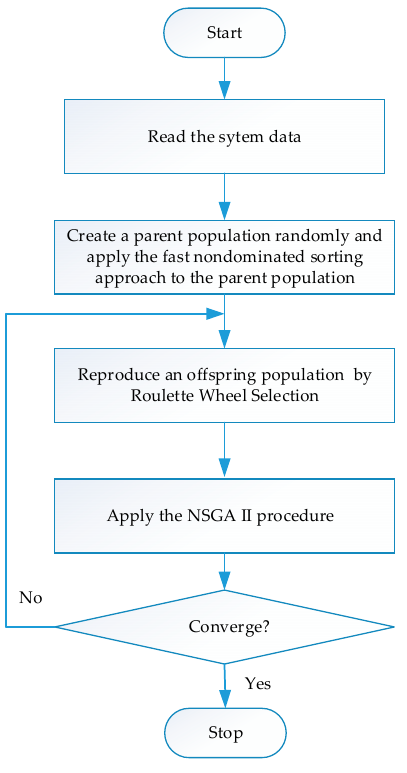
Figure 3. Flowchart of the proposed algorithm.